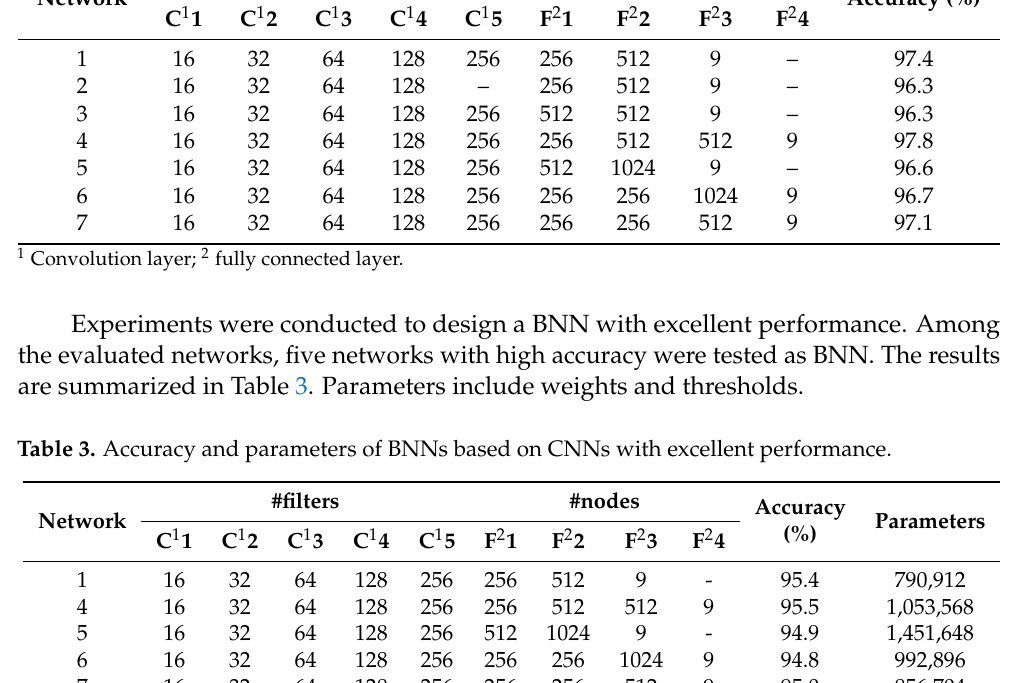
Table 2. Accuracy of CNNs by number of filters and nodes. Network